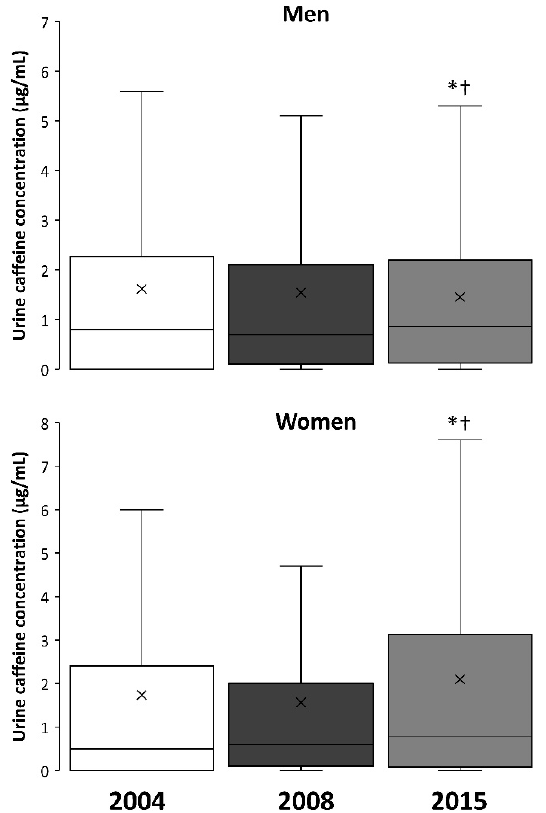
Figure 3. Box-and-whisker plot for caffeine concentrations in the urine samples from men and women collected in 2004, 2008, and 2015. The cross depicts the mean value while the lower, middle and upper lines of the box represent the 25%, 50%, and 75% percentile. Whiskers represent 1.5 × interquartile range. Outlier data have been removed to facilitate the comprehension of the figure. (*) Different from 2004 at p < 0.05; (†) Different from 2008 at p <